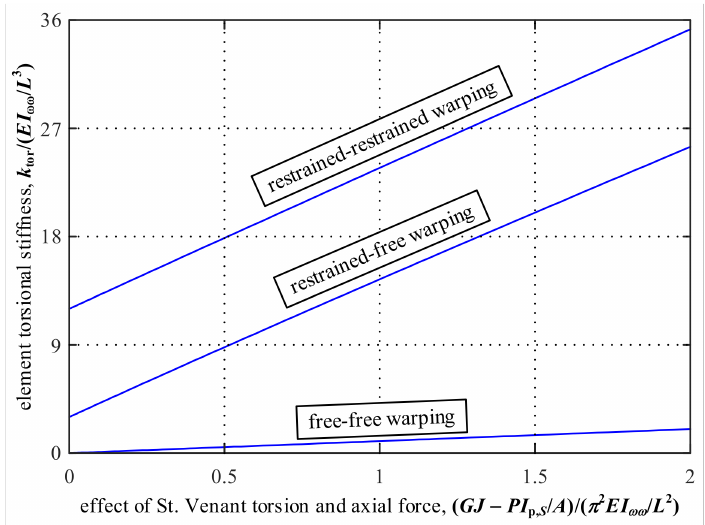
Figure 5. Comparisons of torsional stiffnesses for the three typical warping